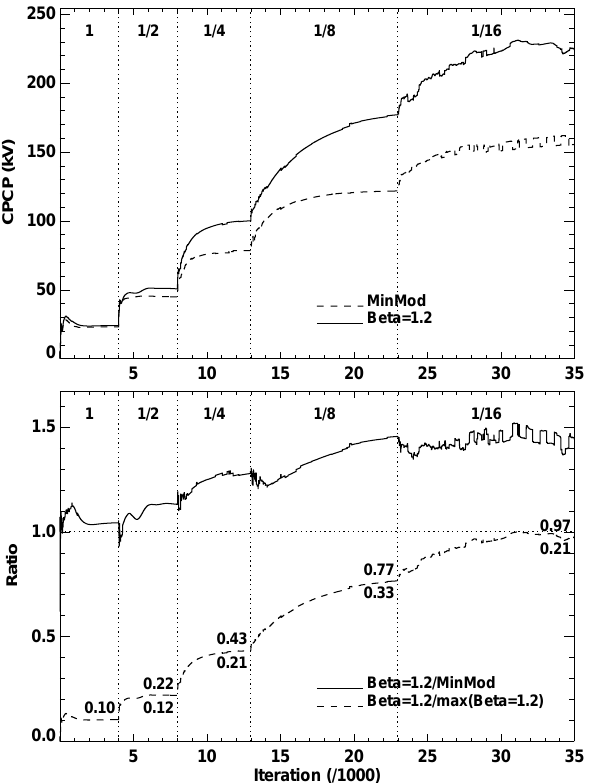
Fig. 7. The top figure shows the ionospheric cross polar cap poten- tial as a function of run-time, with a minmod limiter (dashed) and MC limiter, with β = 1 . 2 (solid). The smallest grid cell size (in R E ) is indicated above the solid line. The bottom figure shows the ratio between the cross polar cap potentials derived from the simulations using the MC and minmod limiters as a function of